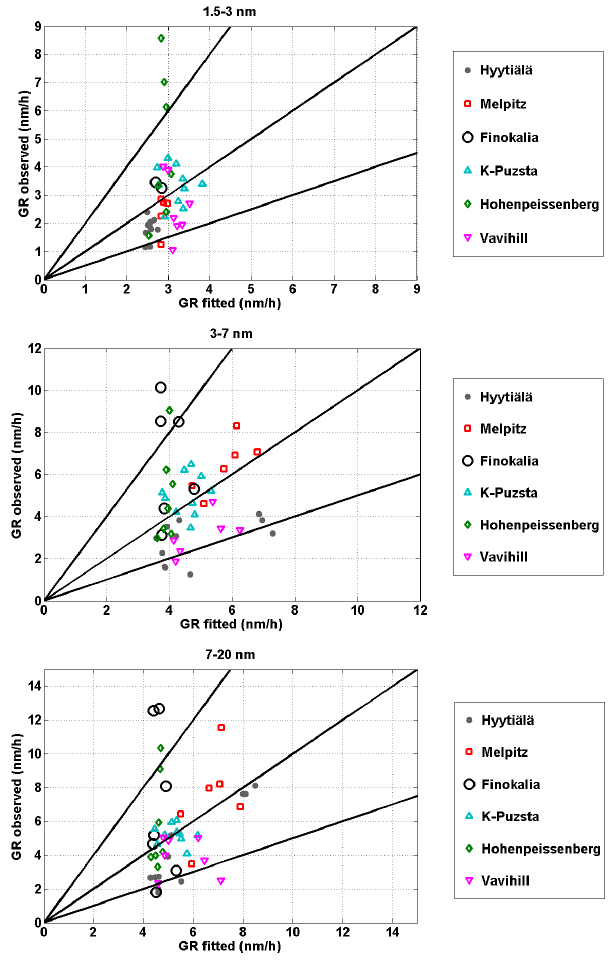
Fig. A1. Comparison of the observed monthly median growth rates from the EUCAARI stations and those reproduced by the parame- terization (see Table 4 for the parameters) for 1.5–3nm, 3–7nm and 7–20nm particles. The data are the same as in Fig.